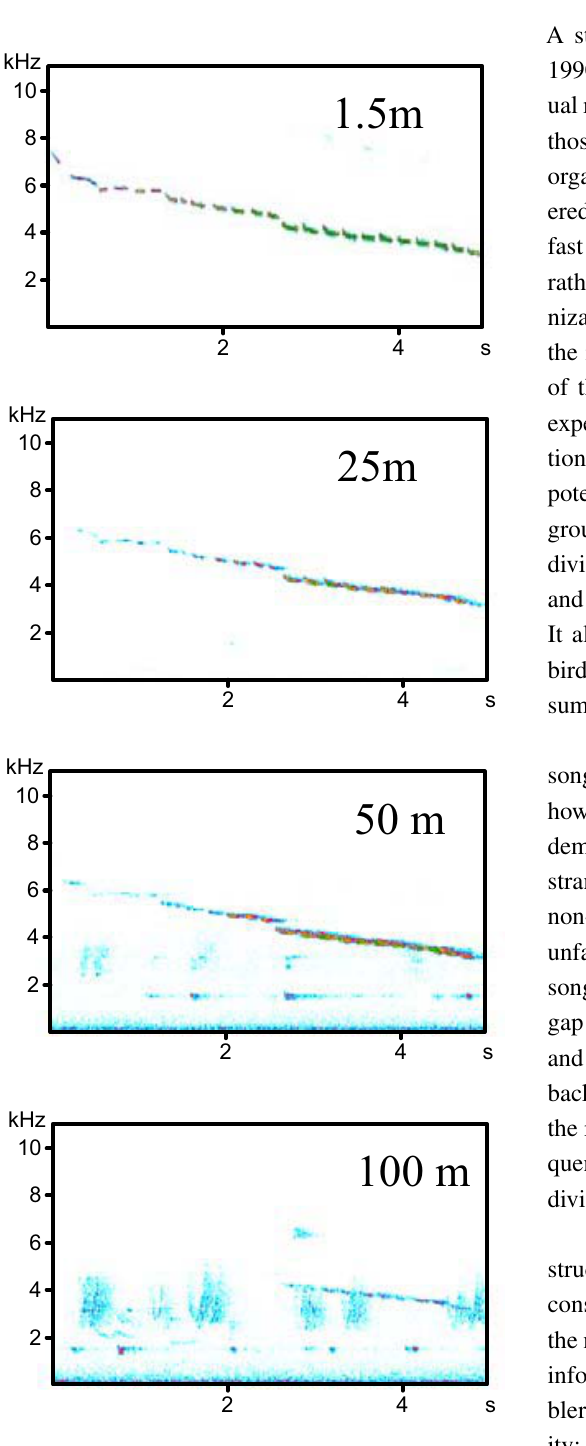
Fig. 5 –Averaged (n=3) spectrograms of a song played-back and recorded at 4 distances in the